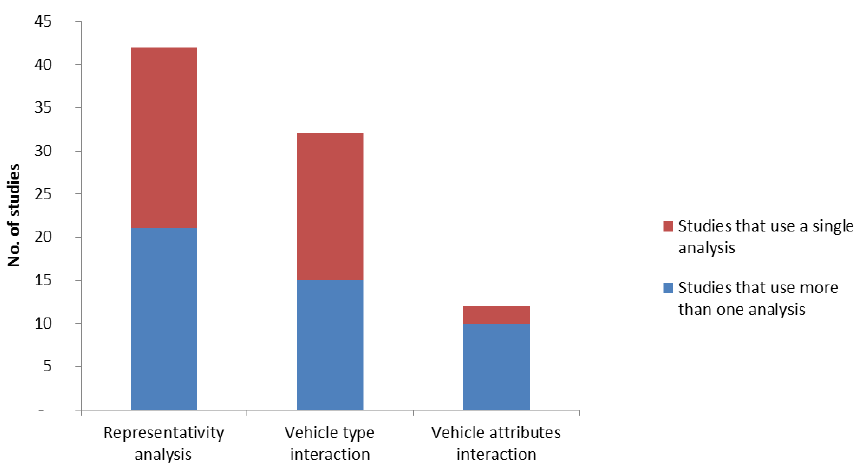
Figure 6. Purpose of collecting demographic data.